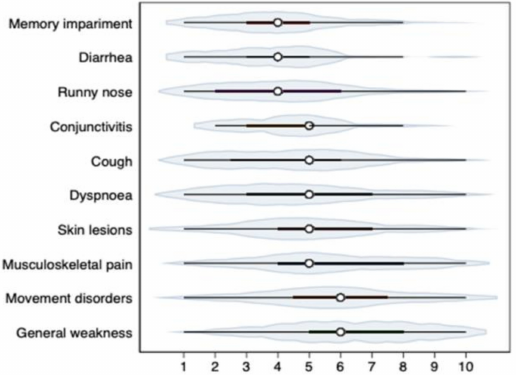
Figure 3. Severity of systemic symptoms assessed on the VAS scale (1–10). Note . The violin plots show medians (points), interquartile ranges (thick horizontal lines), ranges of 95% of observations (thin horizontal